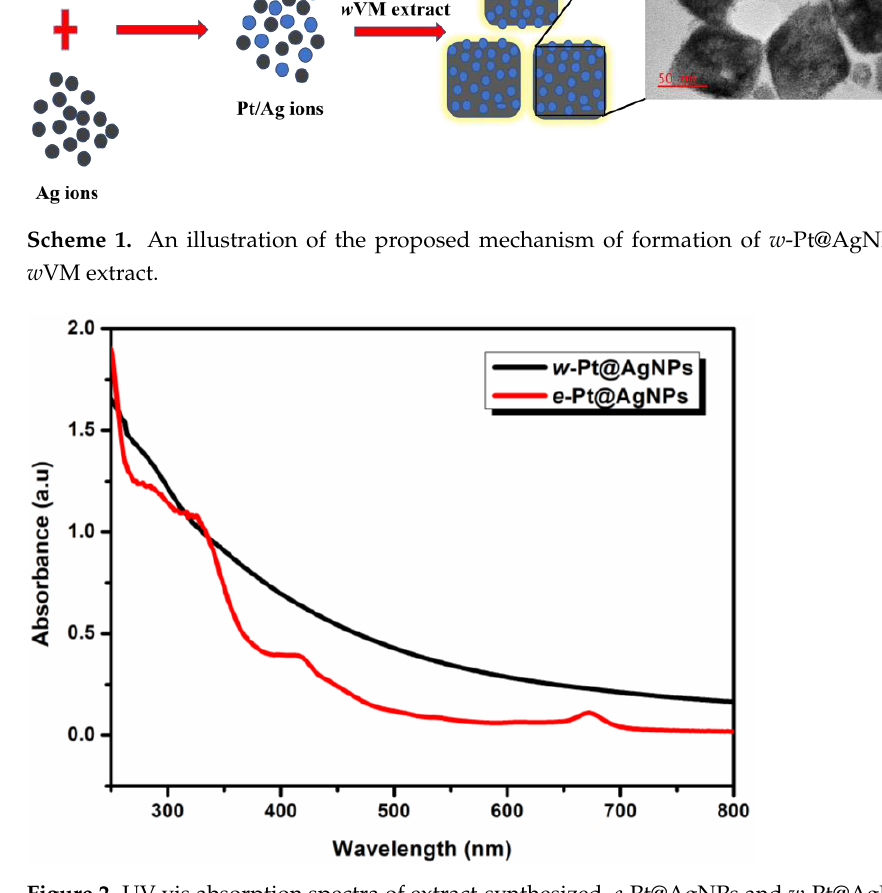
Figure 2. UV-vis absorption spectra of extract-synthesized, e -Pt@AgNPs and w -Pt@AgNPs.